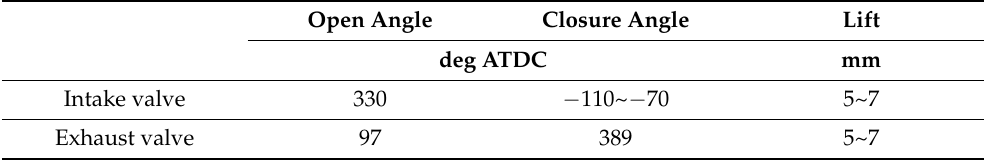
Table 2. Range of variable valve timing.